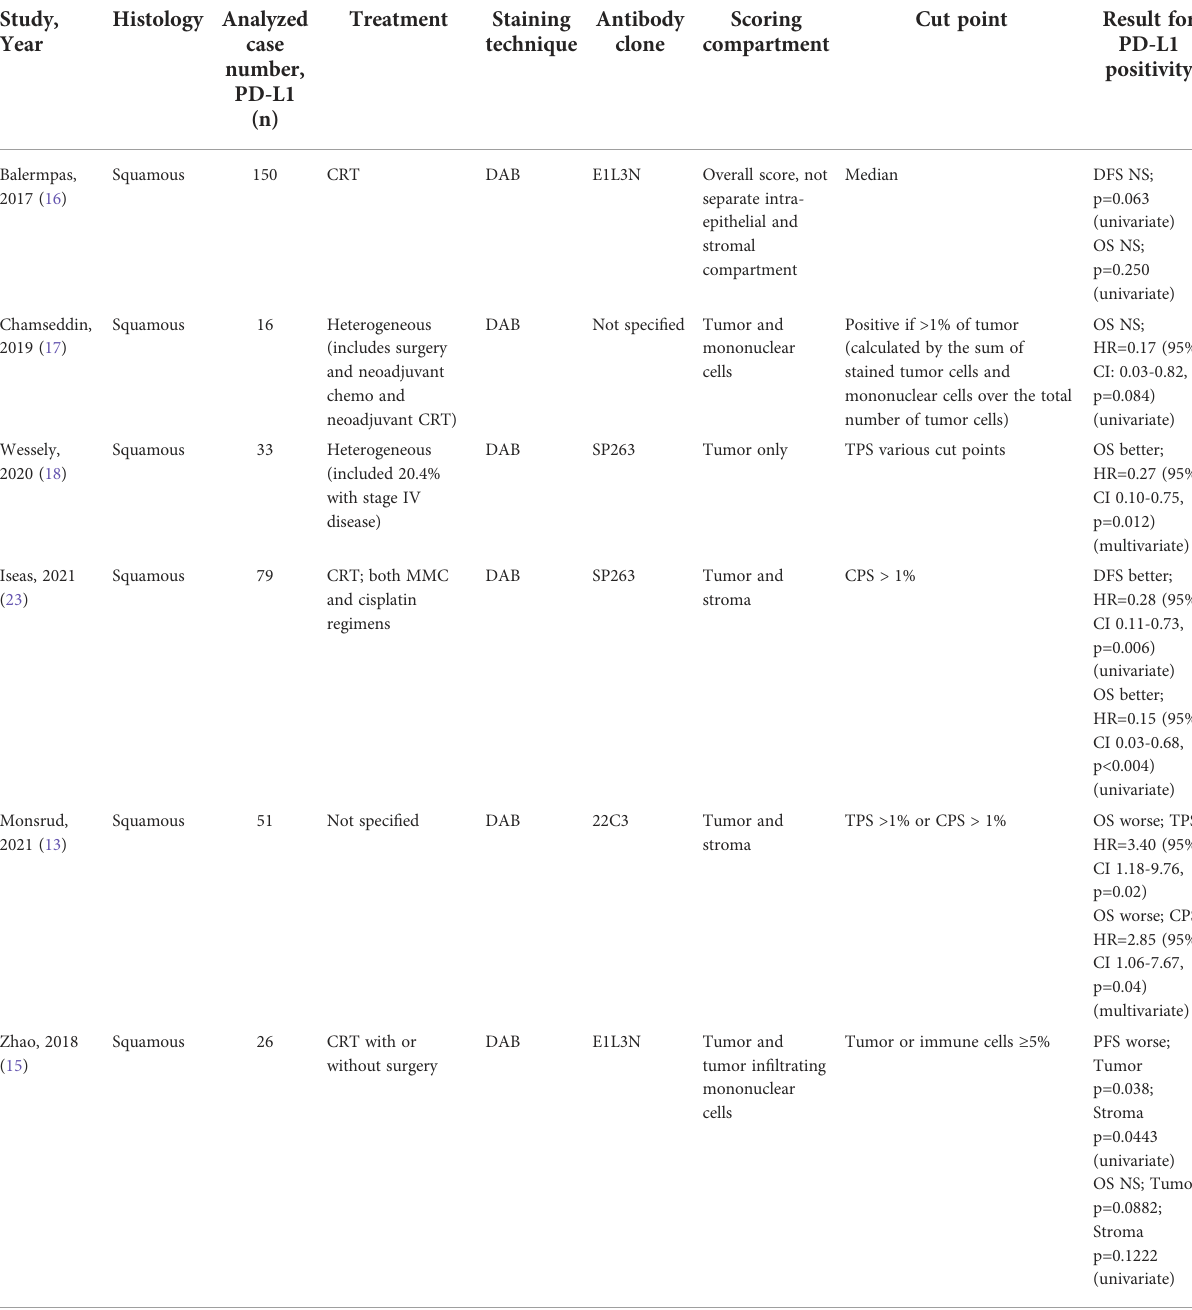
TABLE 4 Summary of PD-L1 evaluation methods and survival results in previous anal cancer